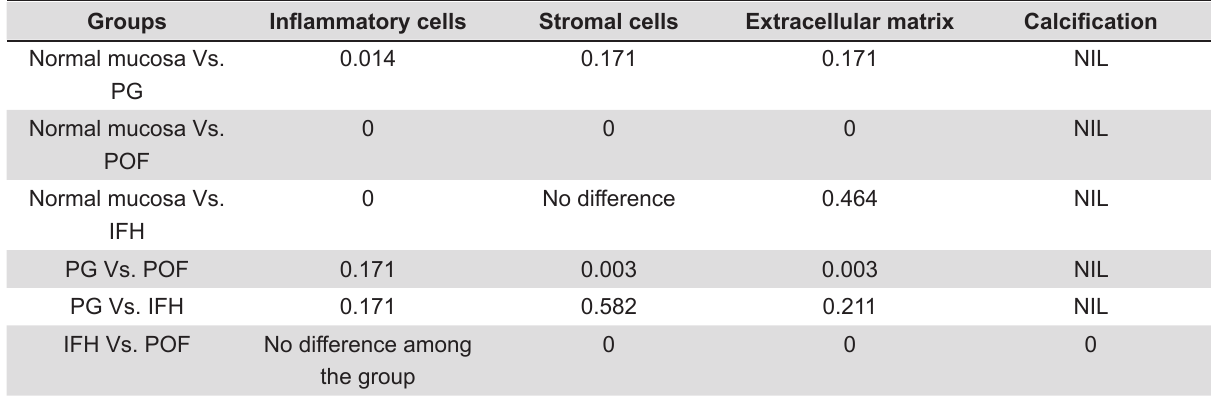
Table 1- Comparison of osteopontin expression between the control group and the study group using Chi-square